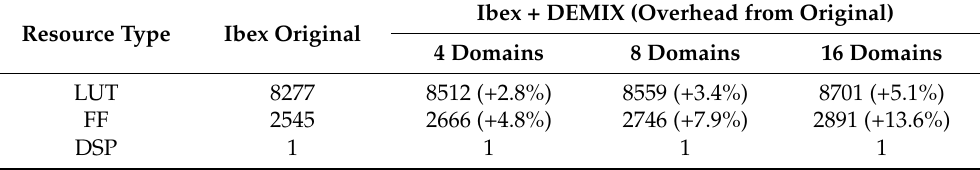
Table 1. FPGA implementation result. The symbol (“+”) signifies the increase in resources in percent- age compared to the standard (i.e., no security) implementation in